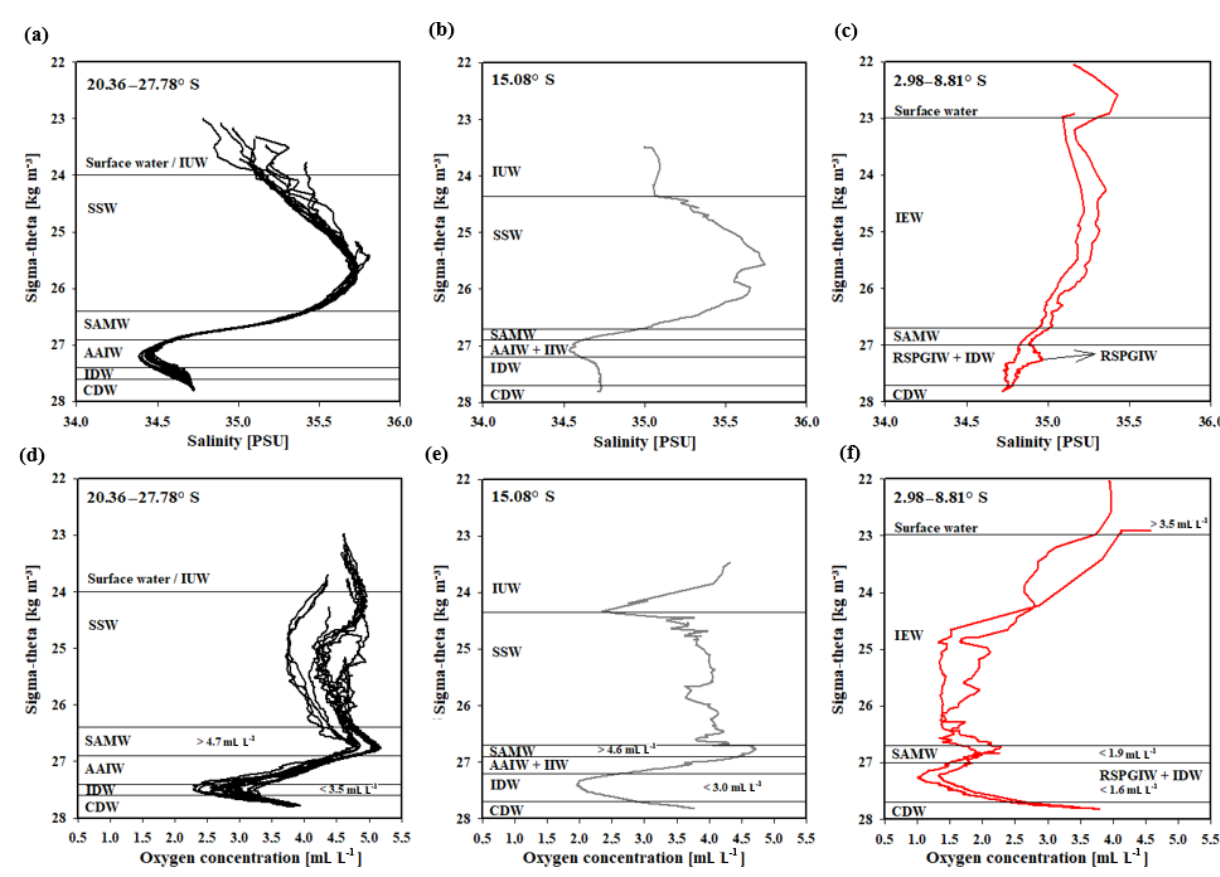
Figure 5. Water mass properties represented as salinity vs. sigma-theta diagrams (a, b, c) and as oxygen vs. sigma-theta diagrams (d, e, f) for CTD stations at latitudes between 20.36 and 27.78 ◦ S, 15.08 ◦ S, and 2.98 and 8.81 ◦ S. For water mass abbreviations see Table